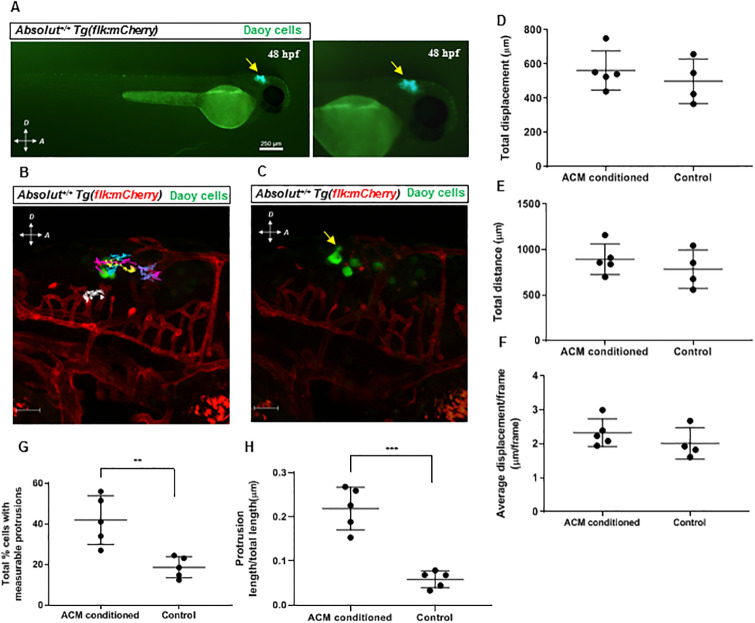
ACM conditioning changes Daoy MB cell morphology in vivo.(A) Representative images of cells (yellow arrow) after injection into the hindbrains of 48 hpf Absolut+/+
Tg(flk:mCherry) zebrafish embryos. Right panel is higher magnification. Scale bar is 250 μm. (B) Representative image of injected cells at the beginning of the time-lapse imaging. Colored lines show the tracked movement of individual cells during the time-lapse imaging, and the white line shows the tracked reference point movement. Scale bar is 50 μm. (C) Representative image of injected cell protrusion (yellow arrow). Scale bar is 50 μm. (D-F) Quantification of injected cell migration, represented by total cell displacement (D) and total distance (E) moved by all cells in first 12.5 hours (h) of imaging, and average displacement/frame (F) of cells through entire 24 h time lapse. (G-H) Quantification of injected Daoy cell protrusion formation, measured by average percent of visible cells with protrusions (G) and protrusion length to cell body size ratio (H). Quantified values expressed as mean +/- SD. **p<0.01, ***p<0.001.